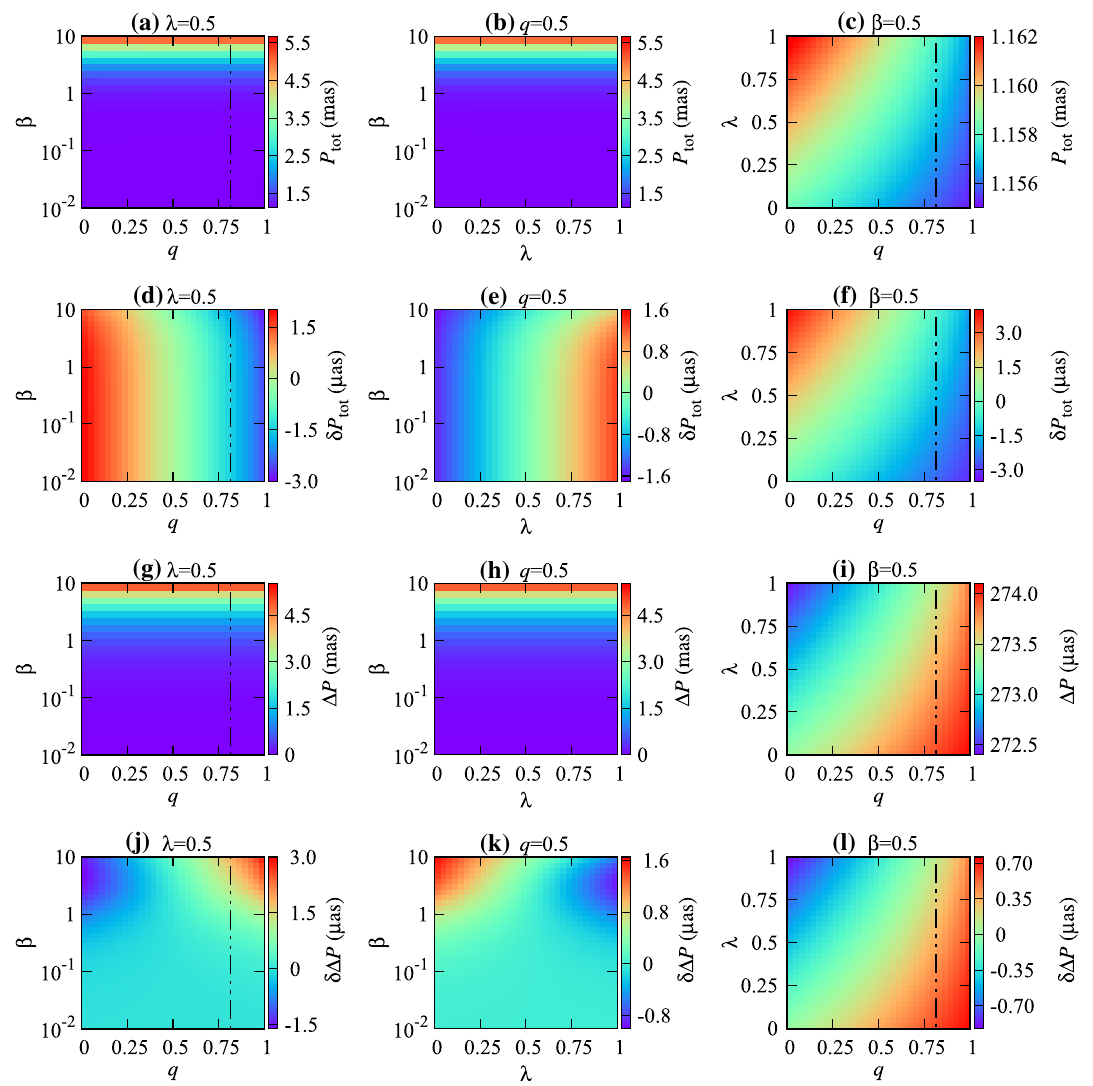
Fig. 2 From top to bottom, color-indexed P tot , δ P tot , Δ P and δΔ P in the weak deflection gravitational lensing for Sgr A* are shown on the domains of D λ , D q and D β (from left to right). The dash-dotted lines mark the upper bound on q based on the shadow of M87* observed by EHT